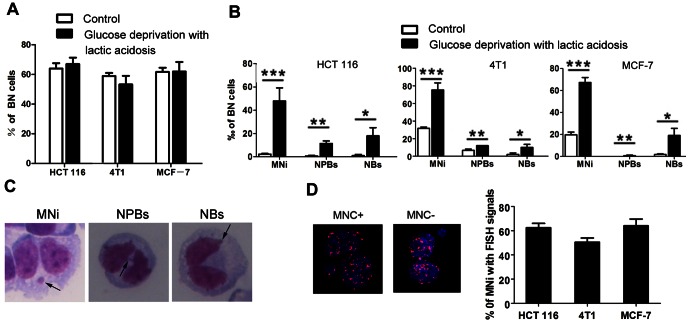
One cycle of glucose deprivation with lactic acidosis followed by nutrient restoration significantly increases micronuclei (MNi), nucleoplasmic bridges (NPBs), and nuclear blebs (NBs) in HCT116, 4T1 and MCF-7 cancer cells.(A) Percentage of binucleated (BN) cells in the cells that were cultured for 7 days as described in Figure 1 and resume mitosis upon nutrient restoration in the presence of cytochalasin B. Control cells are maintained in regular medium without lactic acidosis. (B) The numbers of cells that carry MNi, or NPBs, or NBs in every 1000 BN cells. *p<0.05, **p<0.01, *** p<0.005, in comparison to control. MNi, NPBs and NBs were determined by cytokinesis block micronucleus (CBMN) assay as described in Materials and Methods. (C) Representative photos of MNi, NPBs, and NBs. (D) MNi that contains chromosomes by pancentromeric FISH probes. MNC+, MNi containing whole chromosome; MNC−, MNi containing chromosomal accentric fragment.